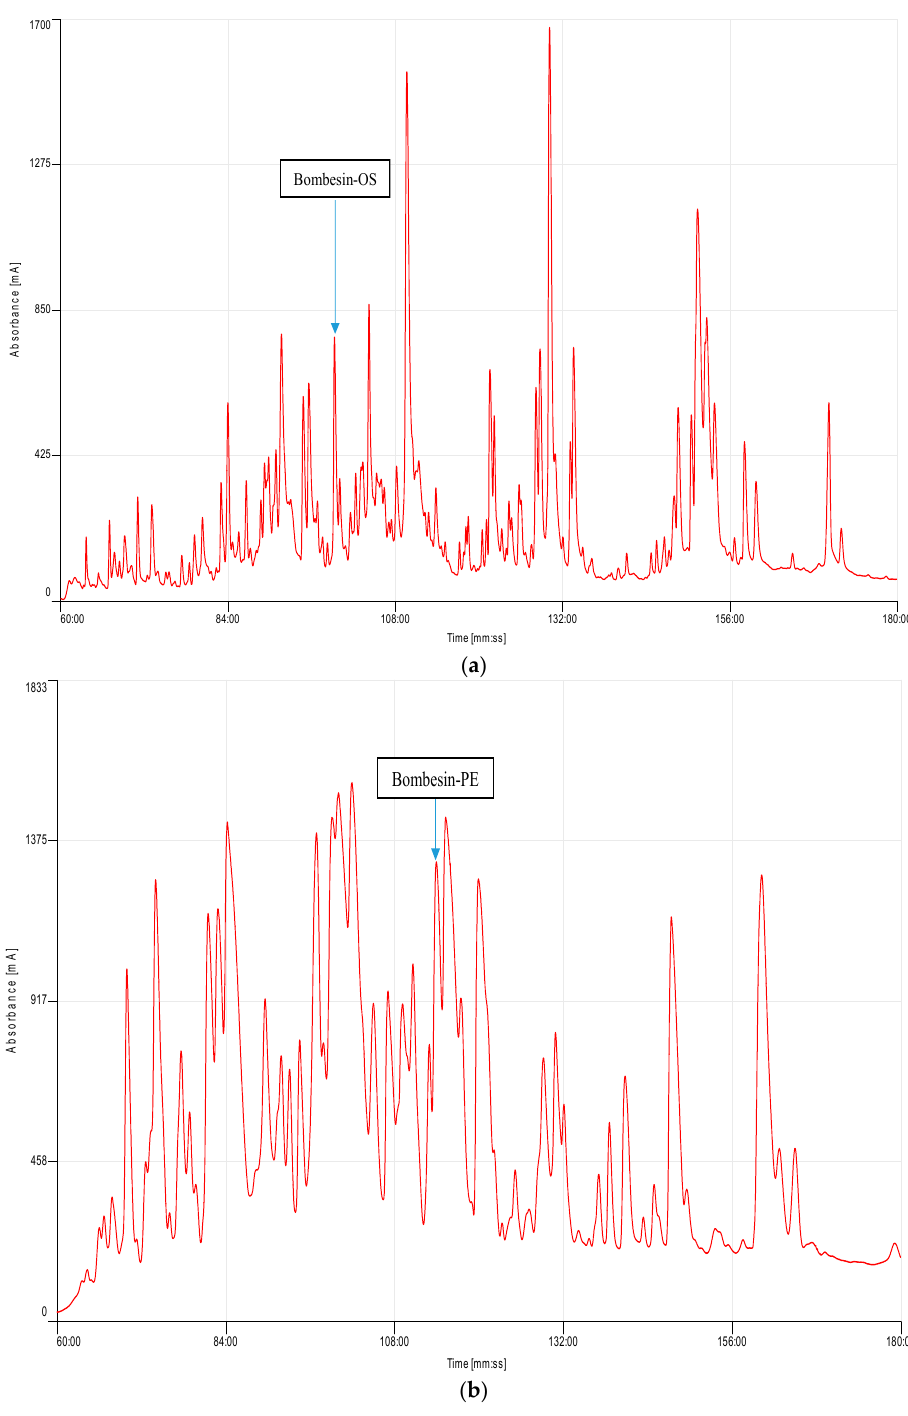
Figure 3. Reverse phase HPLC chromatogram of frog skin secretions. ( a ) HPLC Chromatogram of Chinese piebald odorous frog ( Odorrana schmackeri ); ( b ) HPLC chromatogram of European edible frog ( Pelophylax kl. esculentus ) skin secretion.